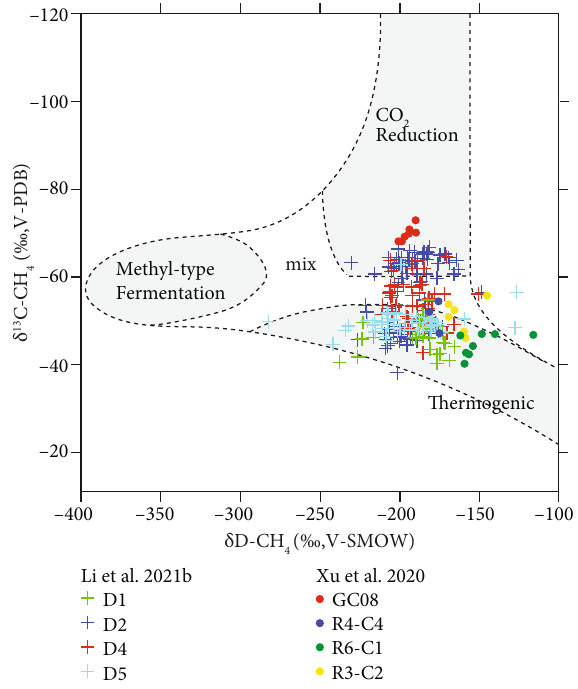
δ D CH 4 vs. CH 4 ) indicating methane